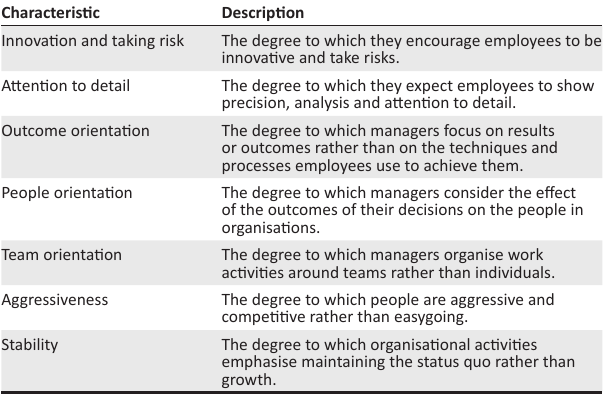
TABLE 1: Overview of culture characteristics organisations often use to express core organisational values.